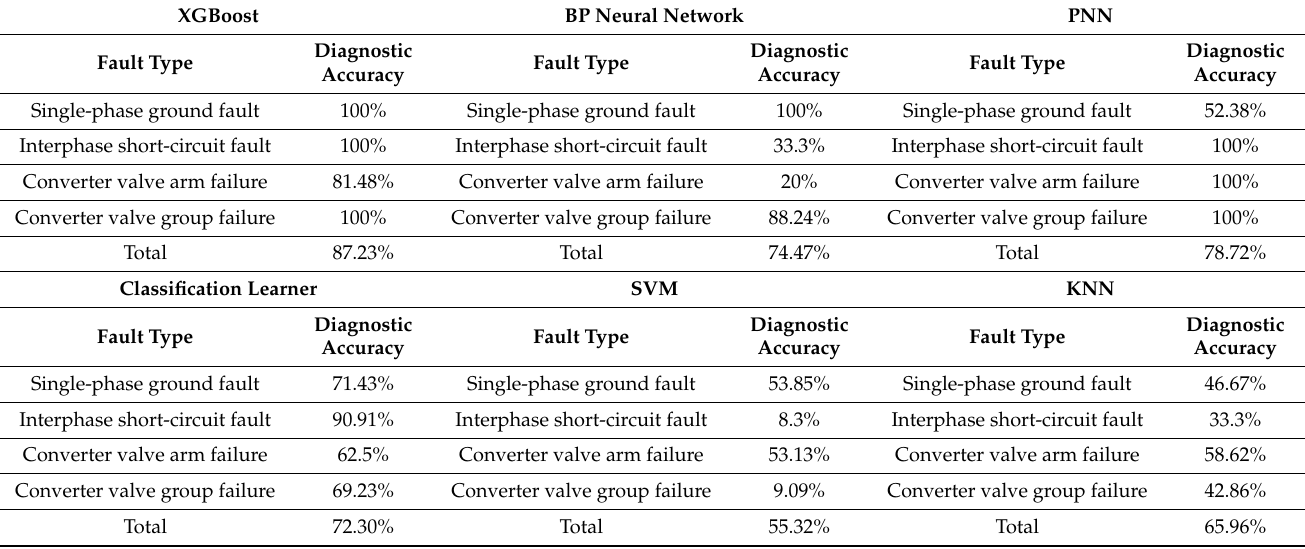
Table 5. Diagnostic accuracy of six methods in four types of faults.